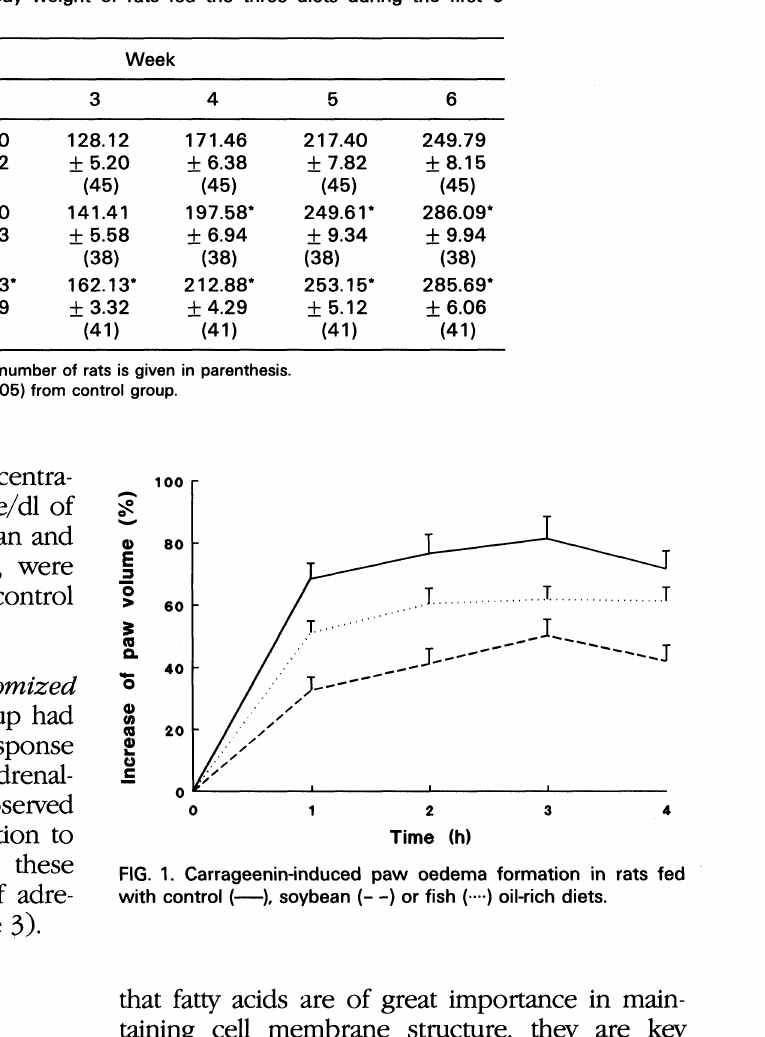
Table 2. Percentage increase in body weight of rats fed the three diets during the first 6 weeks Diet